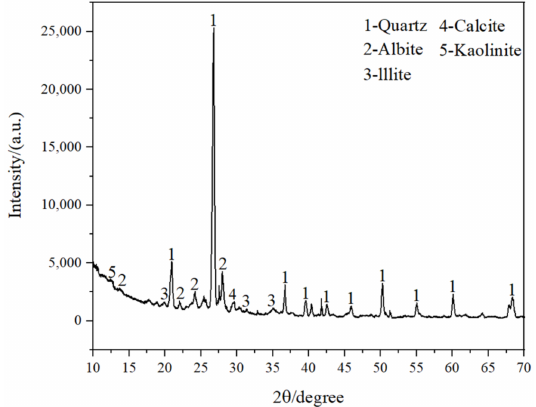
Figure 12. XRD diffraction pattern of different soil samples.